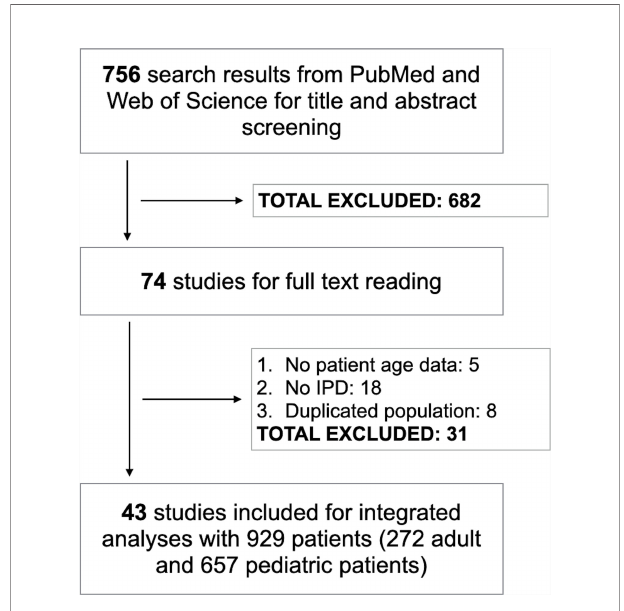
FIGURE 1 | Study fl owchart. IPD, individual participant